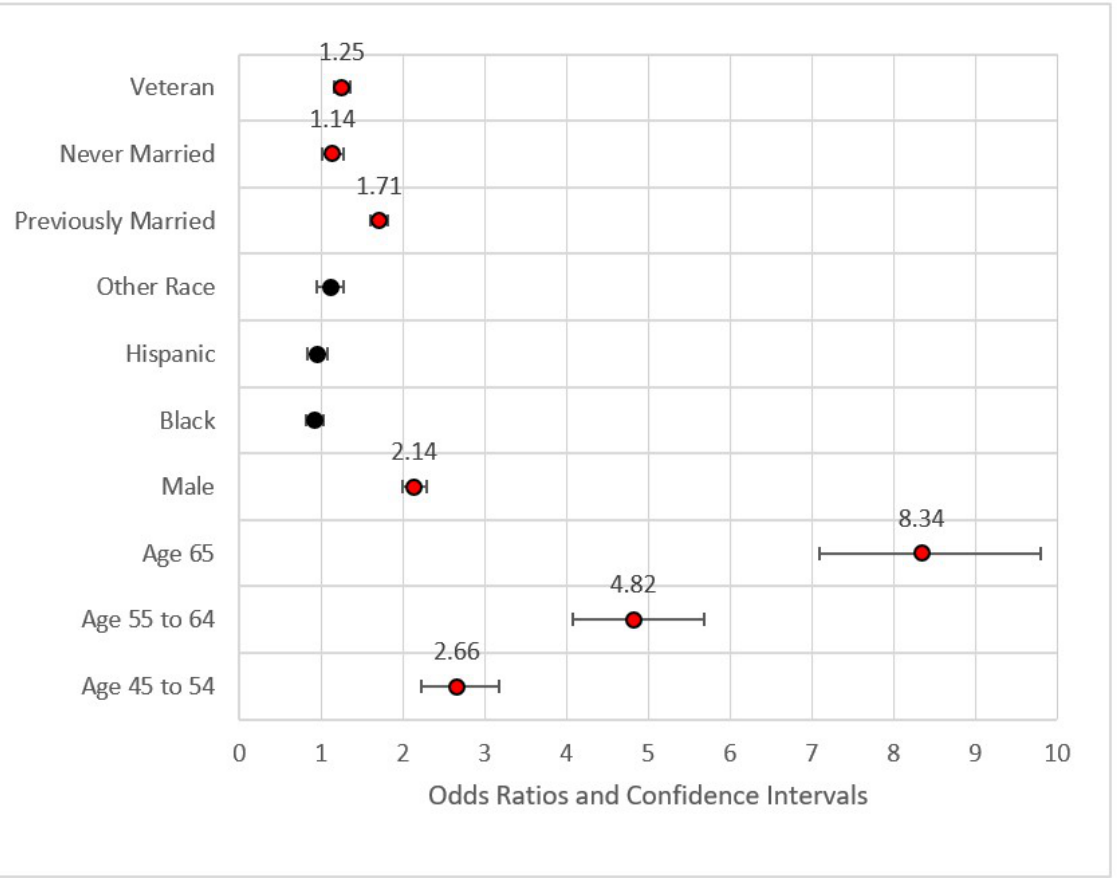
Figure 1. Forest plot of Model 1 (red = significant odds ratios greater than 1.0, black = not significant) .